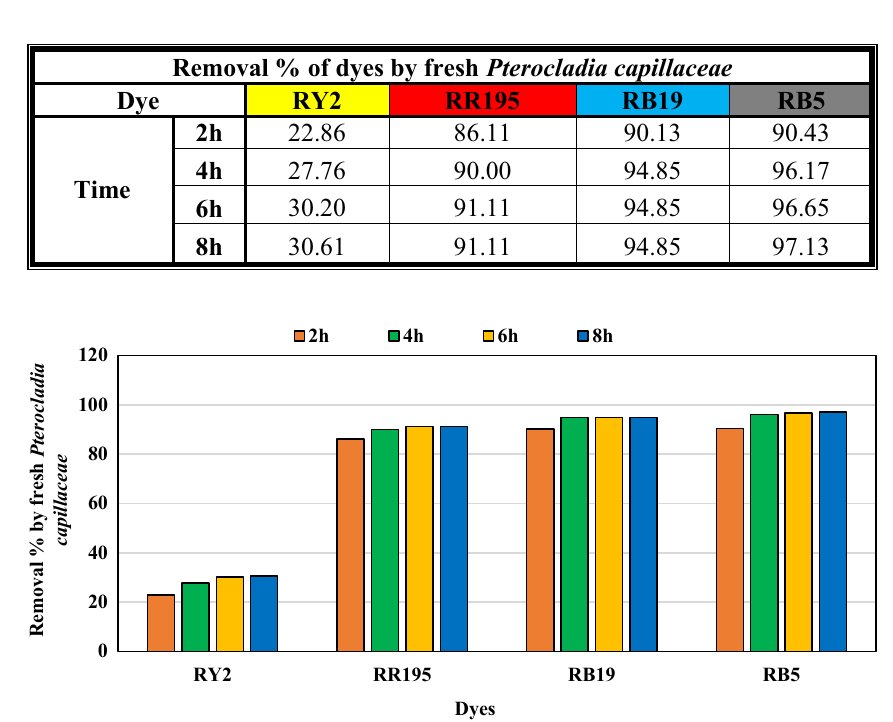
time (at optimized conditions) on the removal percentages of the four studied dyes by fresh Pterocladia capillacea